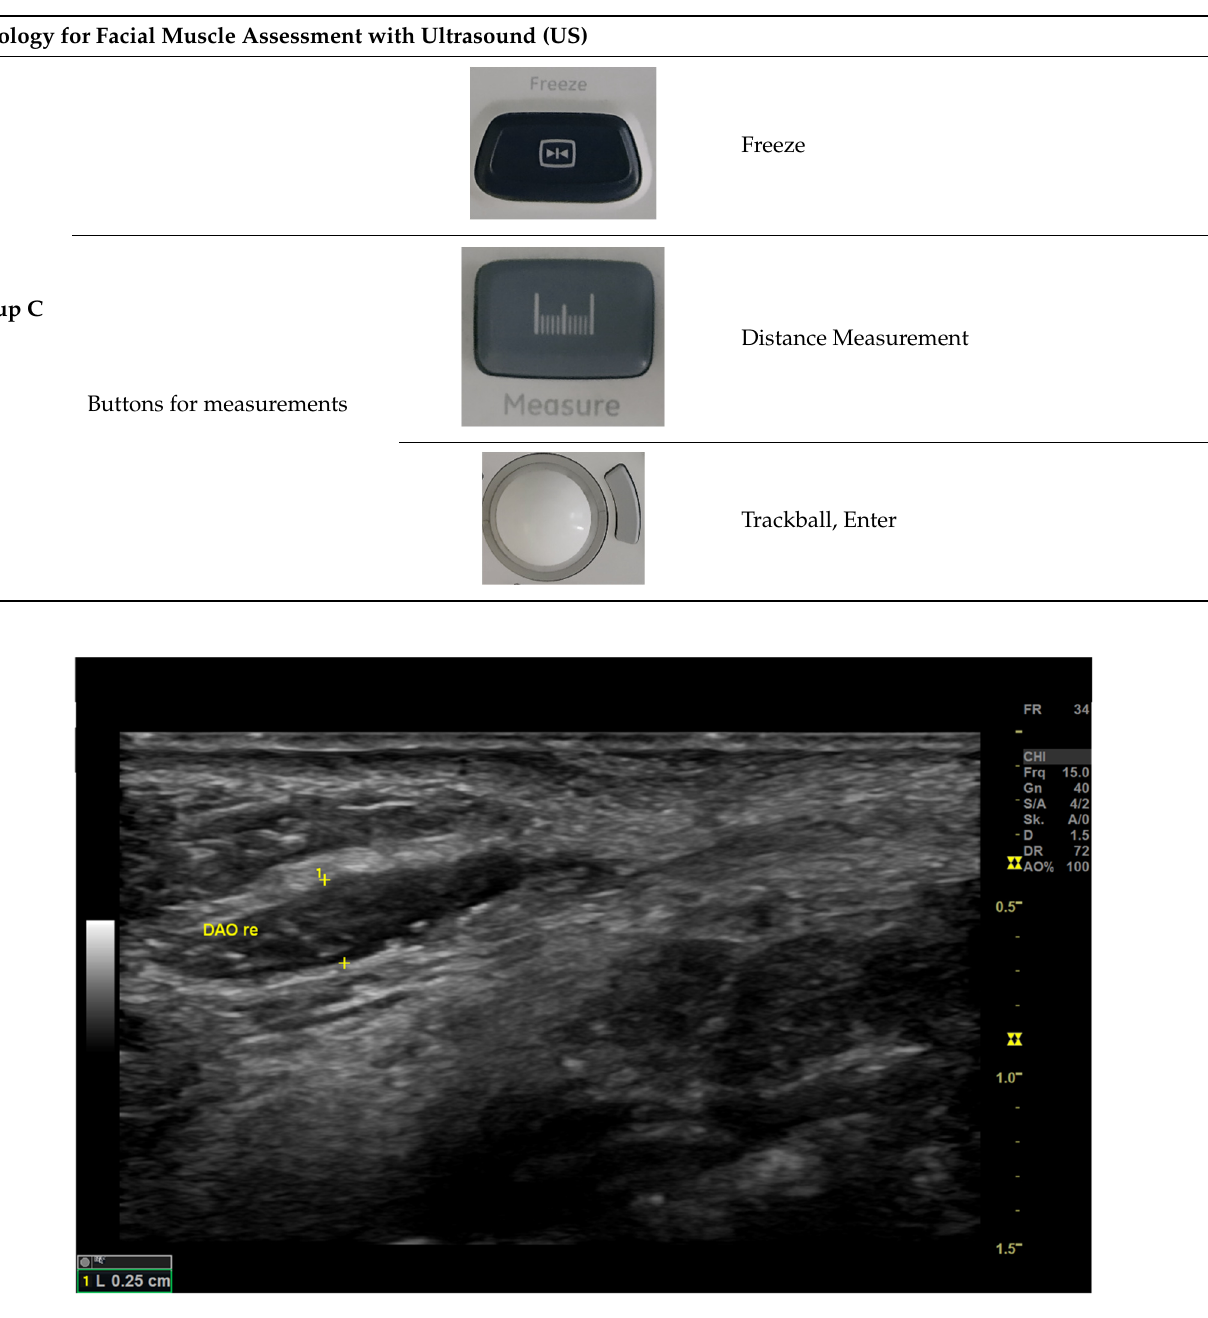
Figure 2. Morphology of the Depressor Anguli Oris (DAO) in the high-resolution brightness (B)- mode examination. Using the preset program Small Parts and the B-mode, the DAO is depicted on the patient’s right facial side. Frq= Frequency [Hz].